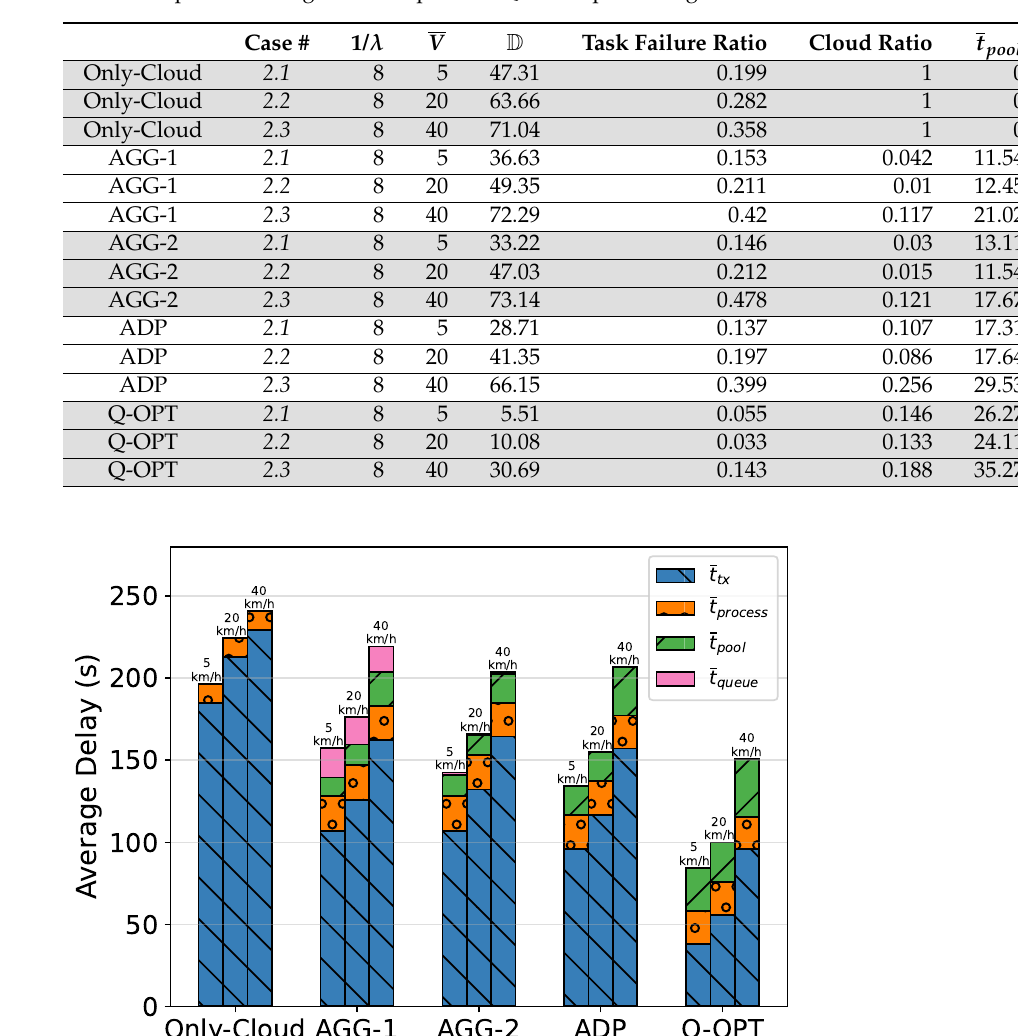
Table 8. Impact of average vehicle speed on QoS and processing characteristics.